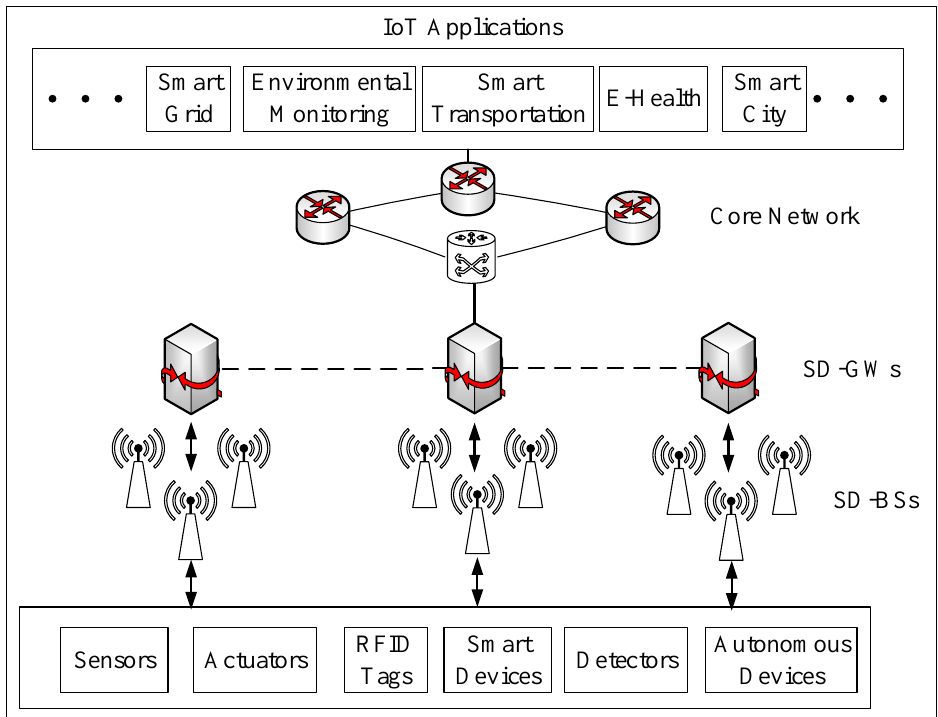
Figure 7. A Network Architecture for Software-Defined